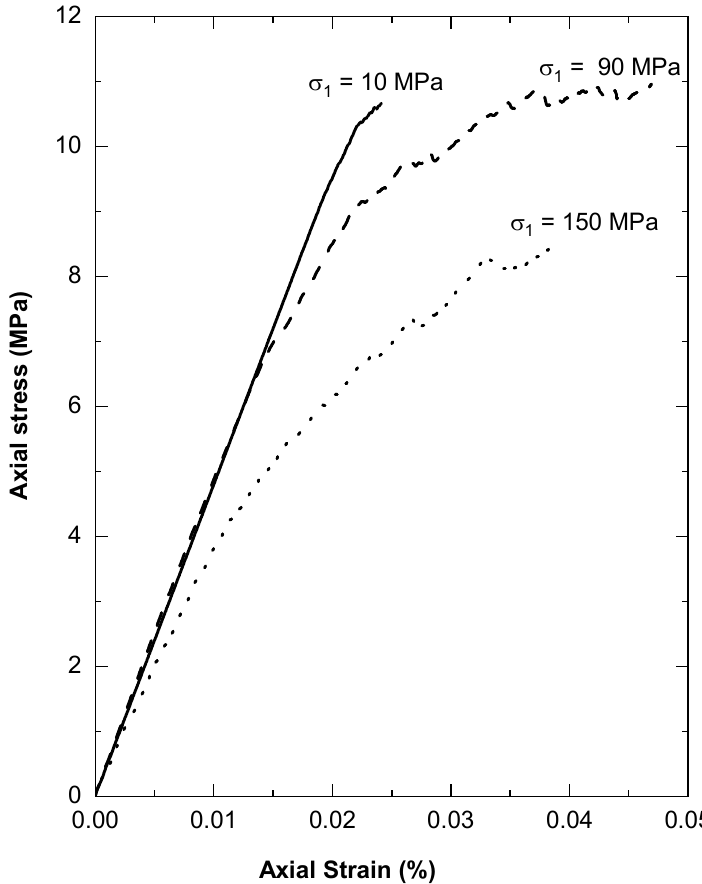
Figure 12. Stress–strain curves obtained for numerical confined extension tests at low (10 MPa), medium (90 MPa), and high (150 MPa) confinements (from point E to point C; Figure 8). In all cases, σ 2 = 0.